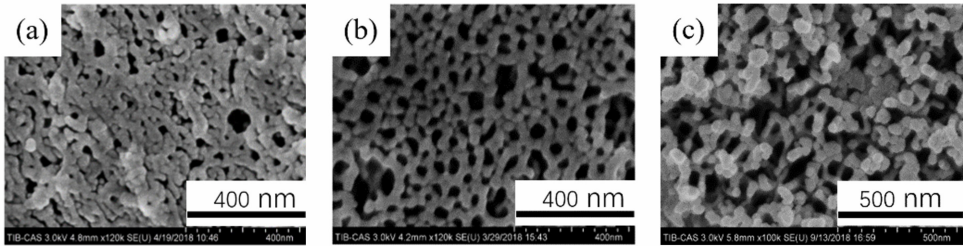
Figure 7. SEM images of 7075 anodic oxide films at different anodic oxidation temperatures: ( a ) 3 °C; ( b ) 21 °C; ( c ) 26